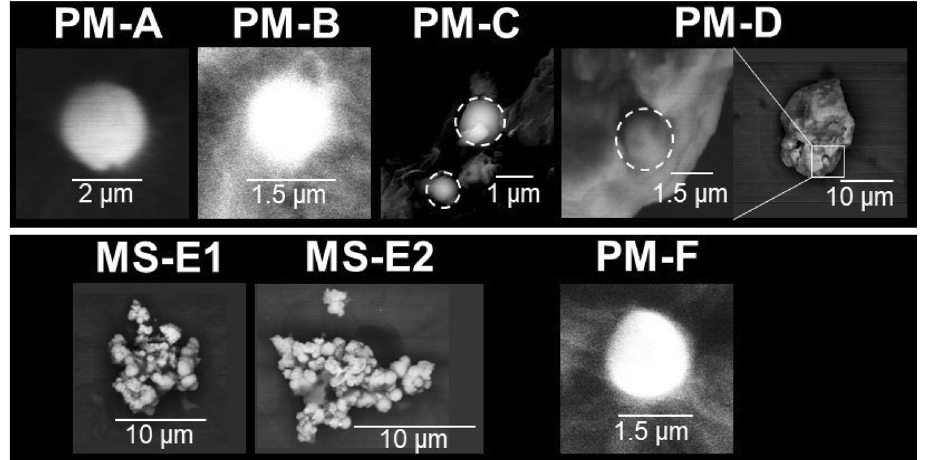
Figure 2. SEM images of the seven radioactive particles (RPs) isolated from marine samples. PM and MS indicate RPs isolated from particulate matter and marine sediment, respectively. RPs were placed on Kapton tape for the SEM–EDS analyses. Cs was detected only in areas within the white dashed circles of each large particles incorporating PM-C and -D.